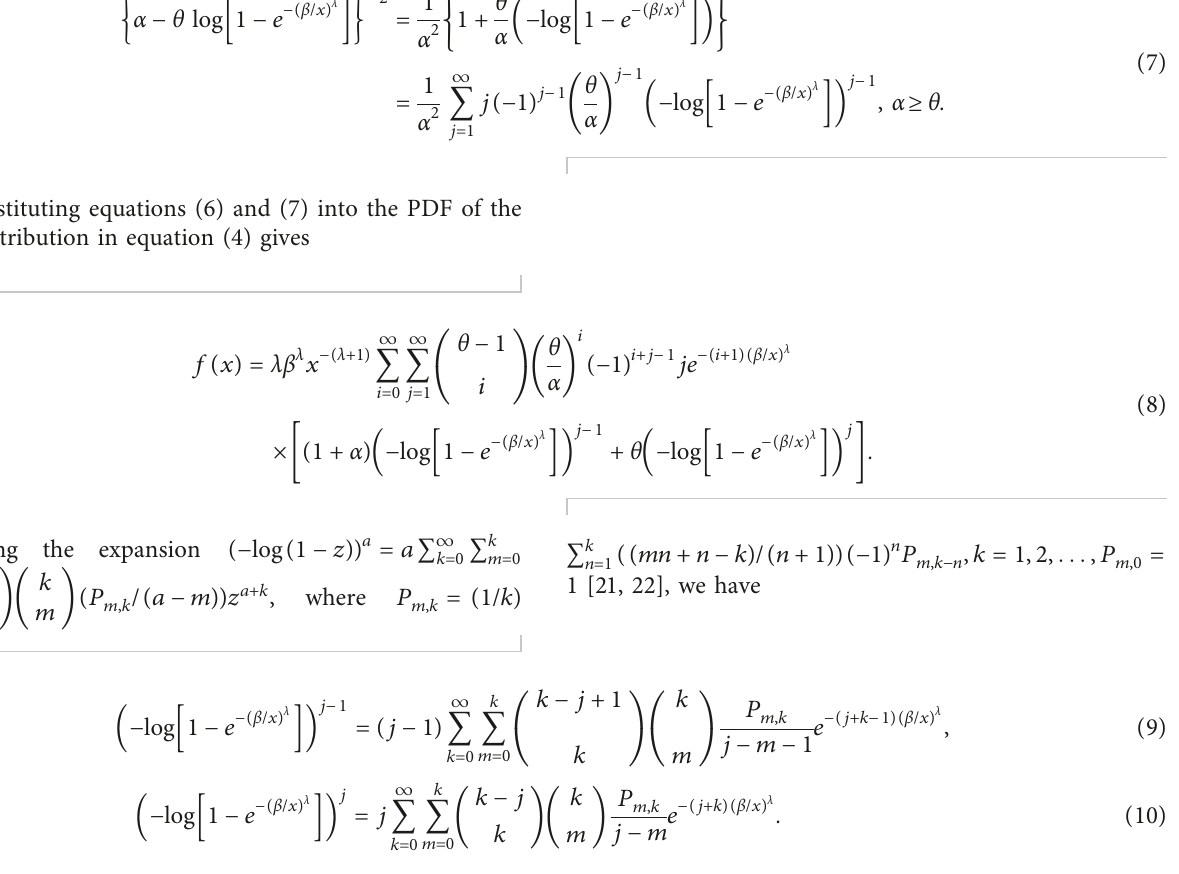
Figure 1: Plots of PDF (a) and hazard rate function (b) of the EFL